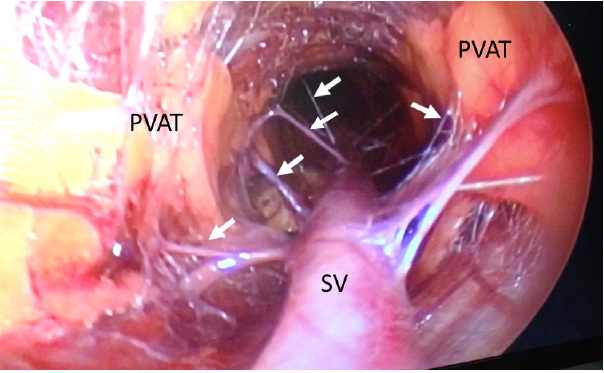
Fig. 2 - Conventional endoscopic saphenous vein (SV) graft harvesting for coronary artery bypass grafting. Screen shot from video footage taken during endoscopic SV harvesting showing exposure of the SV, separation of perivascular adipose tissue (PVAT), and vasa vasorum (arrows). (From Dashwood et al. [62] , 2020). used). In addition, pronounced patches of CD34